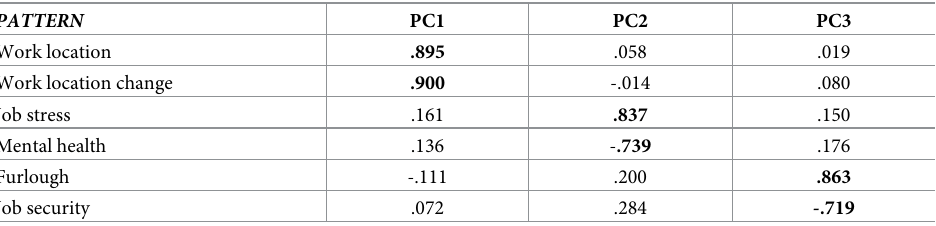
Table 2. Pattern matrix showing loadings of variables on the extracted principal components. PATTERN PC1 PC2